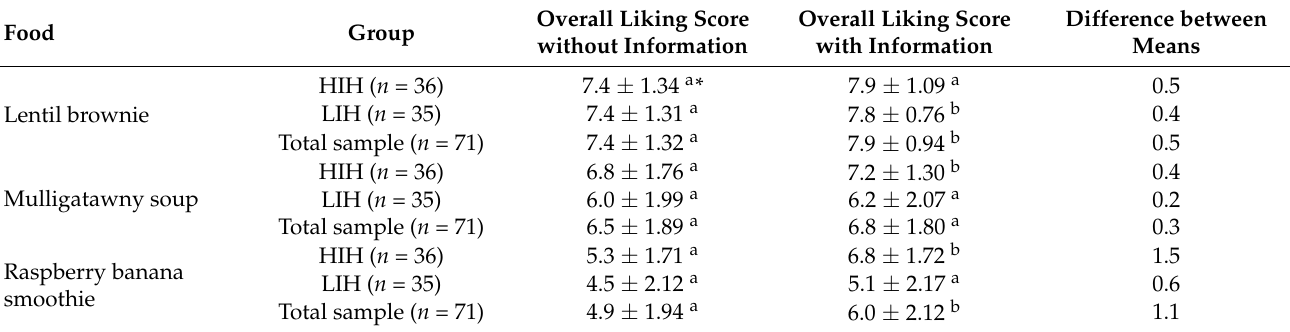
Figure 4. Means and standard deviations for overall liking of ten nutrient-dense foods between healthy eating interest subgroups without health and nutrition information. Y-axis represents the 9-point hedonic scale (1 = dislike extremely, 5 = neither like nor dislike, 9 = like extremely). For each food, values with different letters are significantly different ( p < 0.05). n = 34 for cheese and spinach quiche and tomato cream cheese and wild rice soup in low healthy eating interest group due to missing data. Table 6. Healthy eating interest subgroup differences on mean overall liking with and without information on nutrient- dense ingredients and health benefits for three foods. A 9-point hedonic scale was used (1 = dislike extremely, 5 = neither like nor dislike, 9 = like